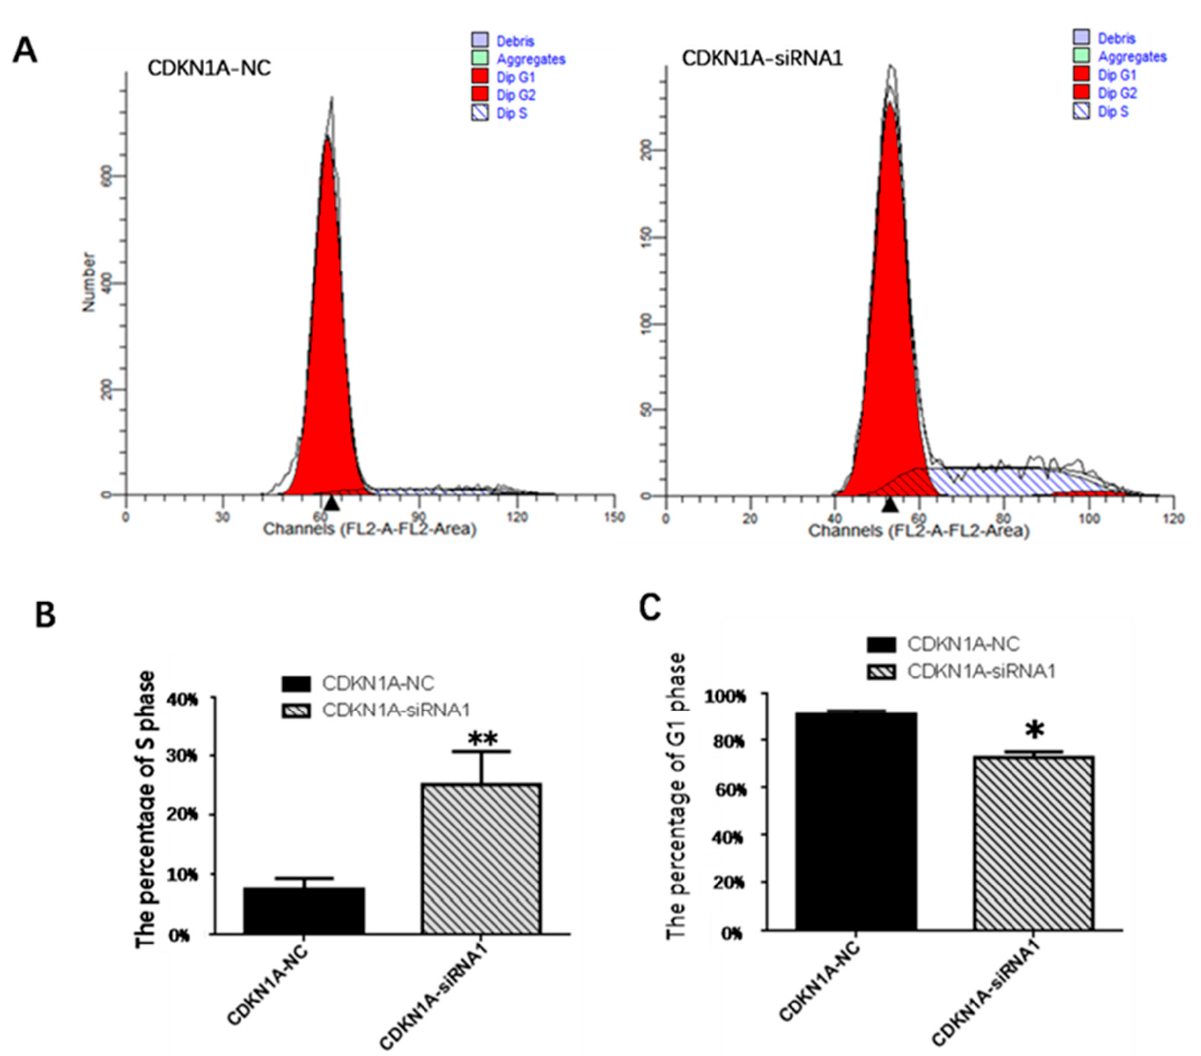
Figure 11. ( A ) Cell cycle analysis of pGCs after transfection of CDKN1A -siRNA1 and CDKN1A -NC. ( B ) Quantification of the S phase by flow cytometry after transfection. ( C ) Quantification of the G1 phase by flow cytometry after transfection, * p < 0.05, ** p < 0.01. All experiments were repeated 3 times.